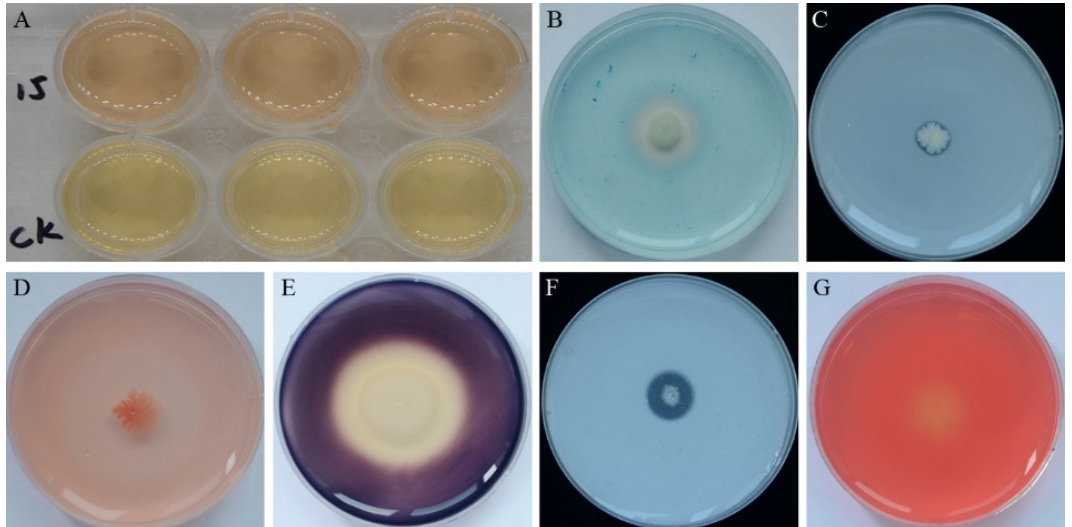
Figure 2. PGP and Antifungal traits of strain YB-15: ( A ) The upper indicating IAA production by pink coloration; ( B ) Yellow-orange halos indicating siderophore production; ( C ) Phosphorus solu- bilization indicated by a halo zone around strain YB-15 colonies; ( D ) β-1, 3-glucanase activity in- dicated by a zone around strain YB-15 colonies; ( E ) Amylase activity indicated by a clear zone around strain YB-15 colonies; ( F ) Protease activity indicated by an obvious hydrolytic zone around strain YB-15 colonies; ( G ) Cellulase activity indicated by a zone of hydrolysis around strain YB-15